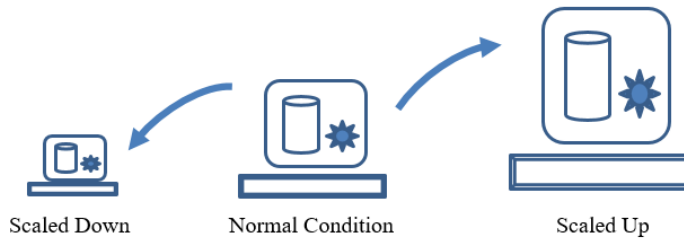
Figure 5. EaaS Adaptable Localize Virtualization Conceptual .